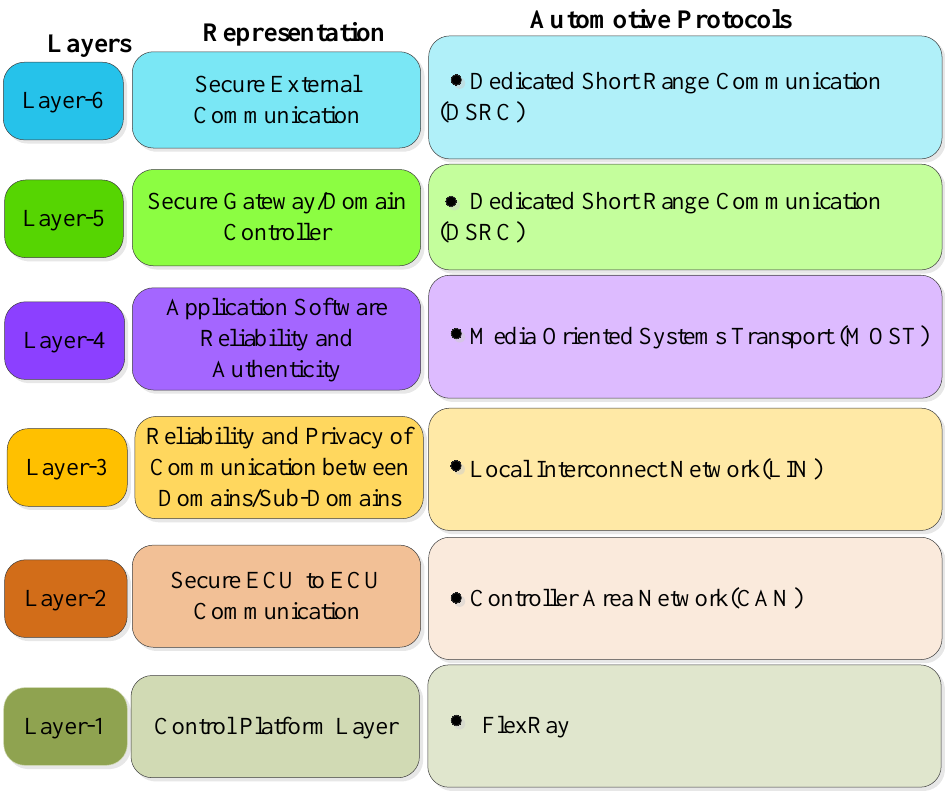
Figure 13. Multi-layered Security Framework for in-Vehicle Network.